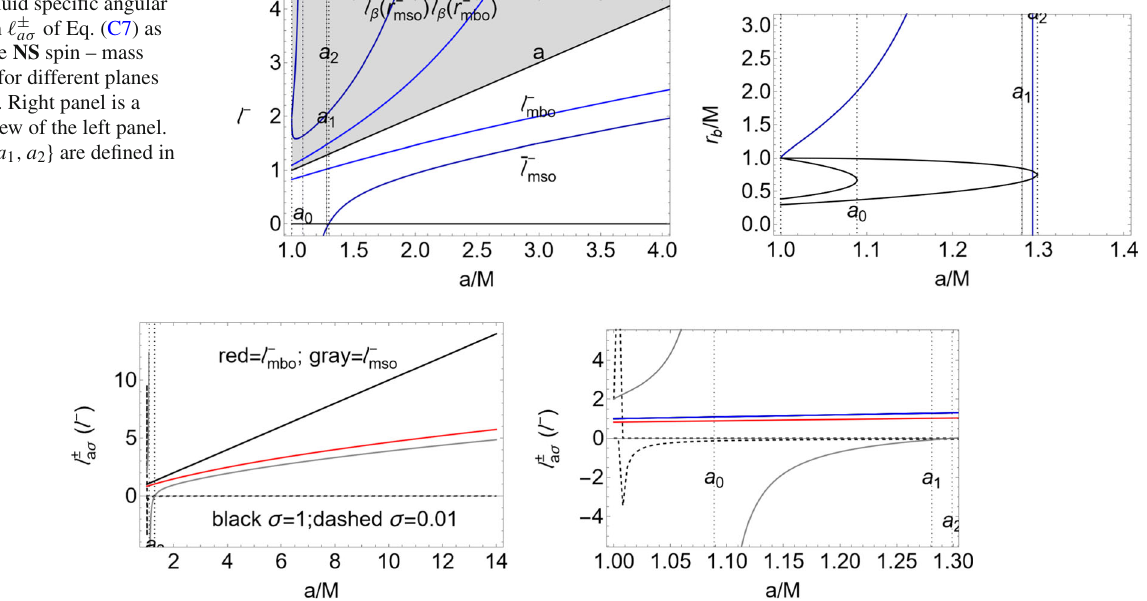
the geodesic structure (relative to fluid momentum (cid:6) − is also shown. Right panel: radius r b is plotted on different momenta according to the colors definitions of the right left panel. Spins { a 0 , a 1 , a 2 } are defined in Table 2. Black curves are radii r − the NS spin a /